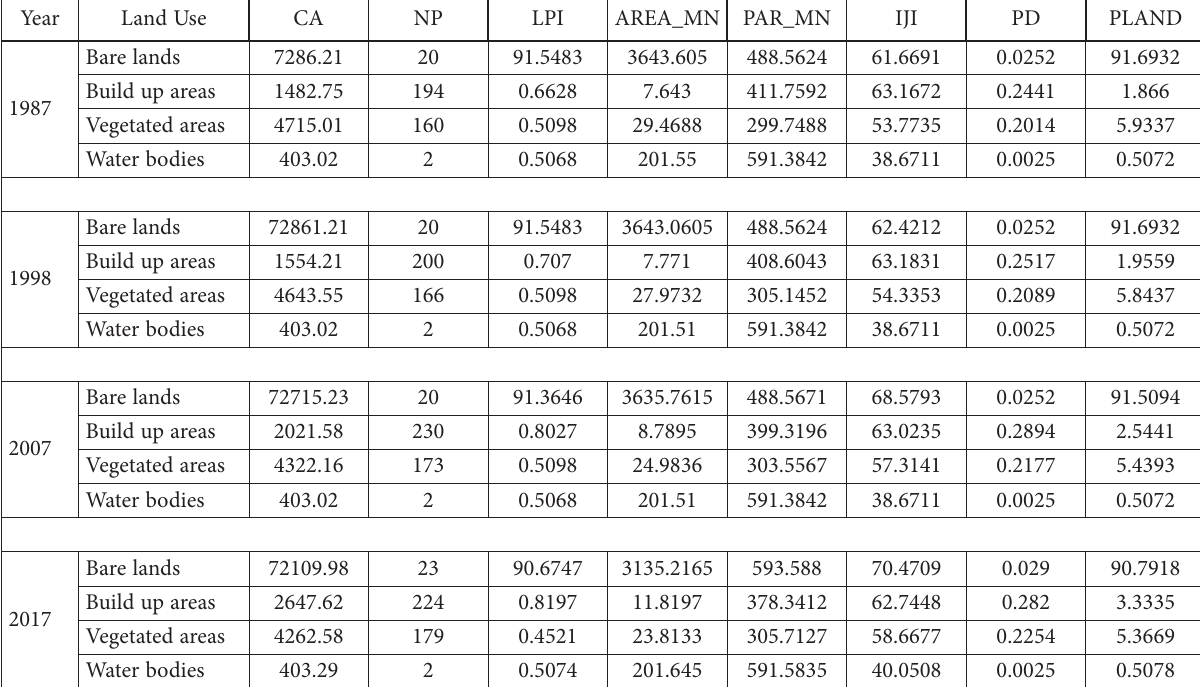
Table 5. Comparison of class and landscape-level metrics during the years 1987 to